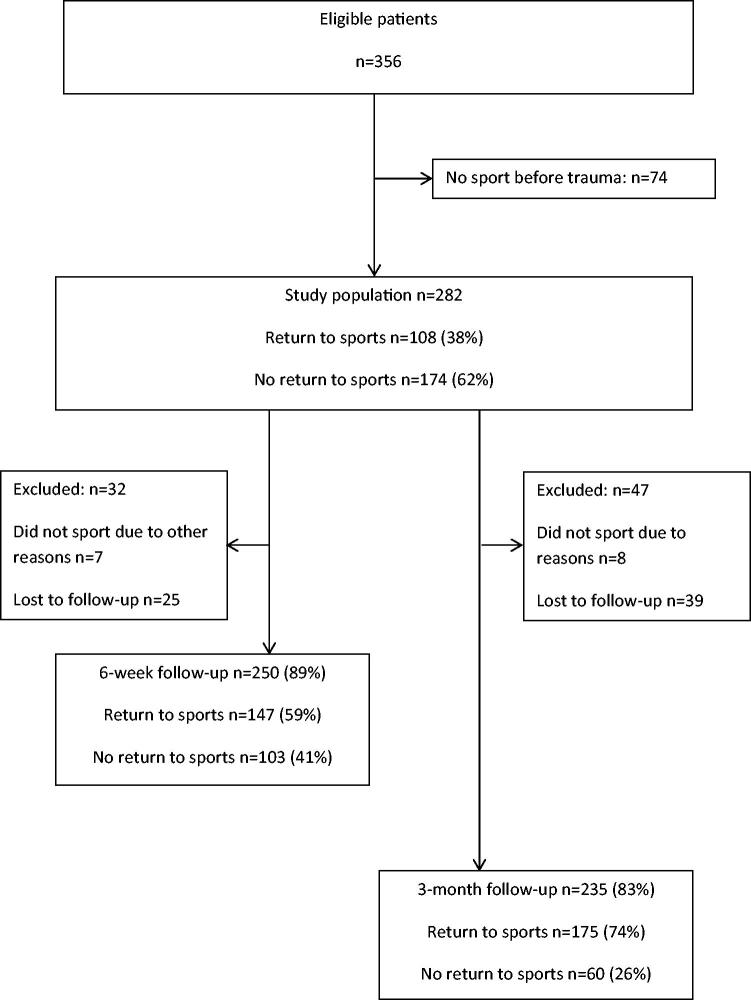
Flow chart of the process.